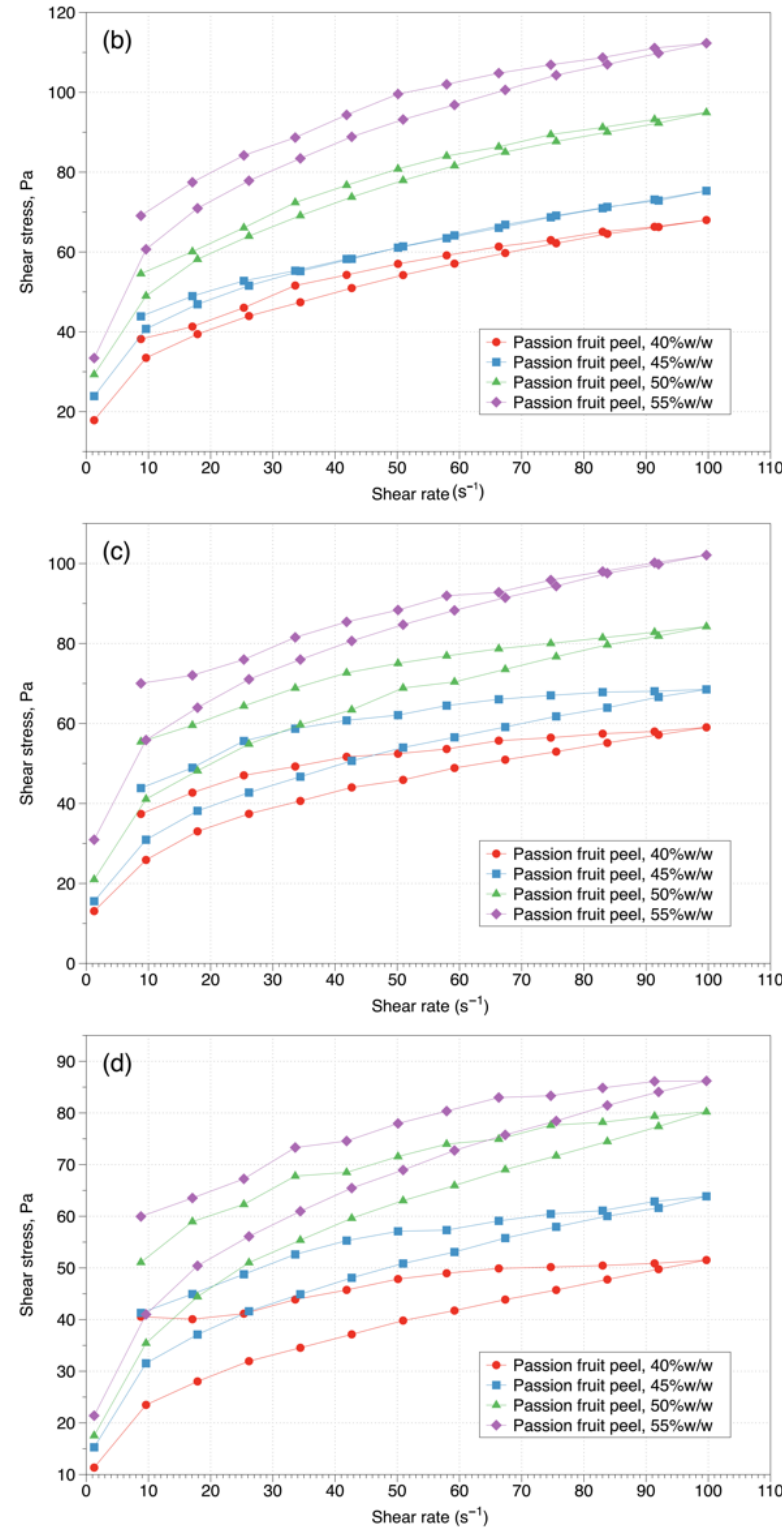
Figure 1. Rheograms of the passion fruit peel extracts at different temperatures. ( a ) 5 °C, ( b ) 10 °C, ( c ) 25 °C, and ( d ) 40 °C.